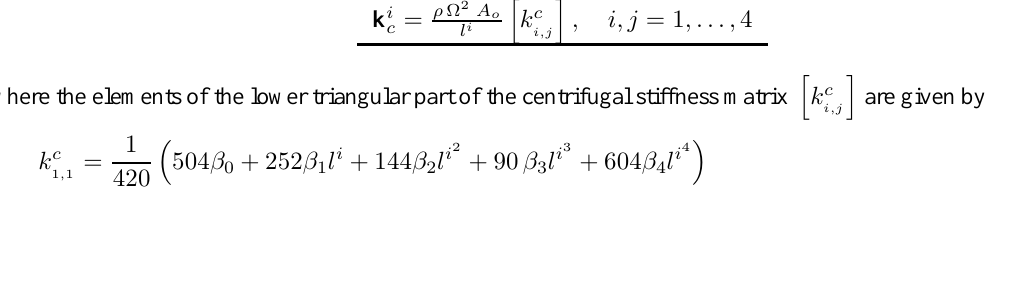
Table A2 Centrifugal stiffness matrix of rotating tapered Euler-Bernoulli beam element. The centrifugal stiffness matrix for tapered Euler-Bernoulli beam is given